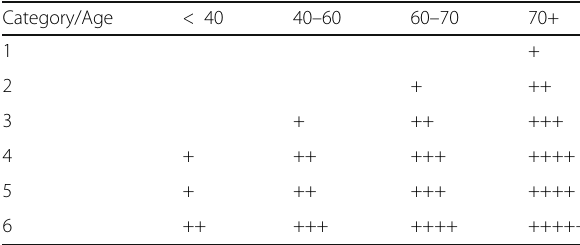
Table 2 Stratification of the theoretical risk of infection with respect to patient age, category according to Fineberg [11] and